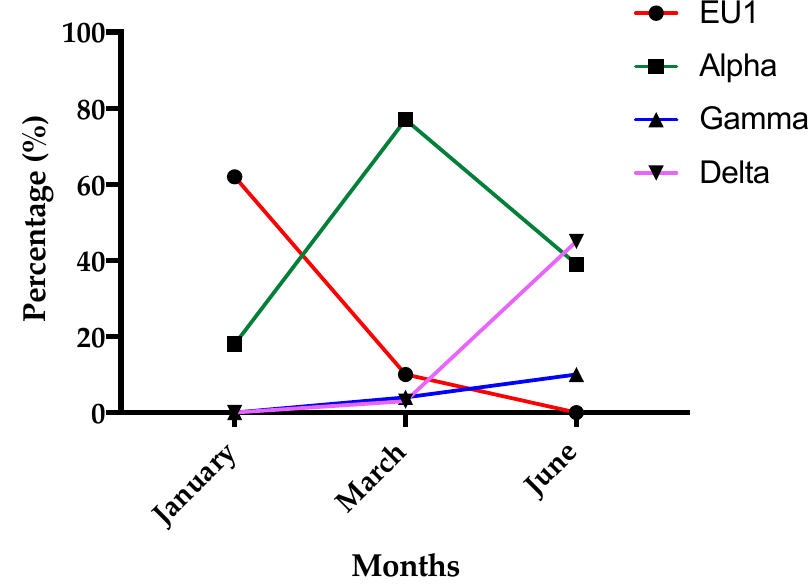
Figure 1. The graph shows the trend of the prevalence of SARS-CoV-2 variants in Italy in the period between 26 March 2021 and 30 June 2021.